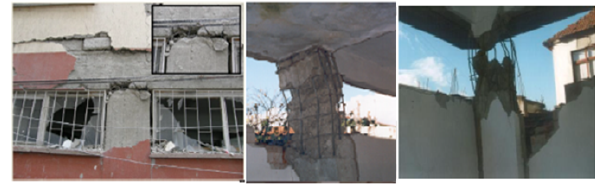
Figure 6. Examples of damage caused by the formation of short columns (METU/EERC, 2011).